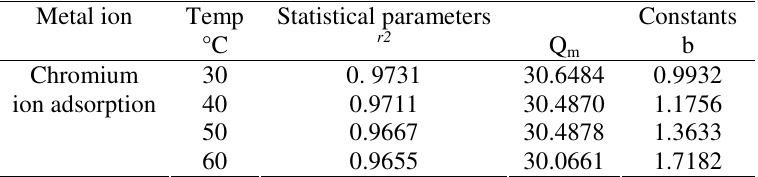
Table 2. Langmuir isotherm results.